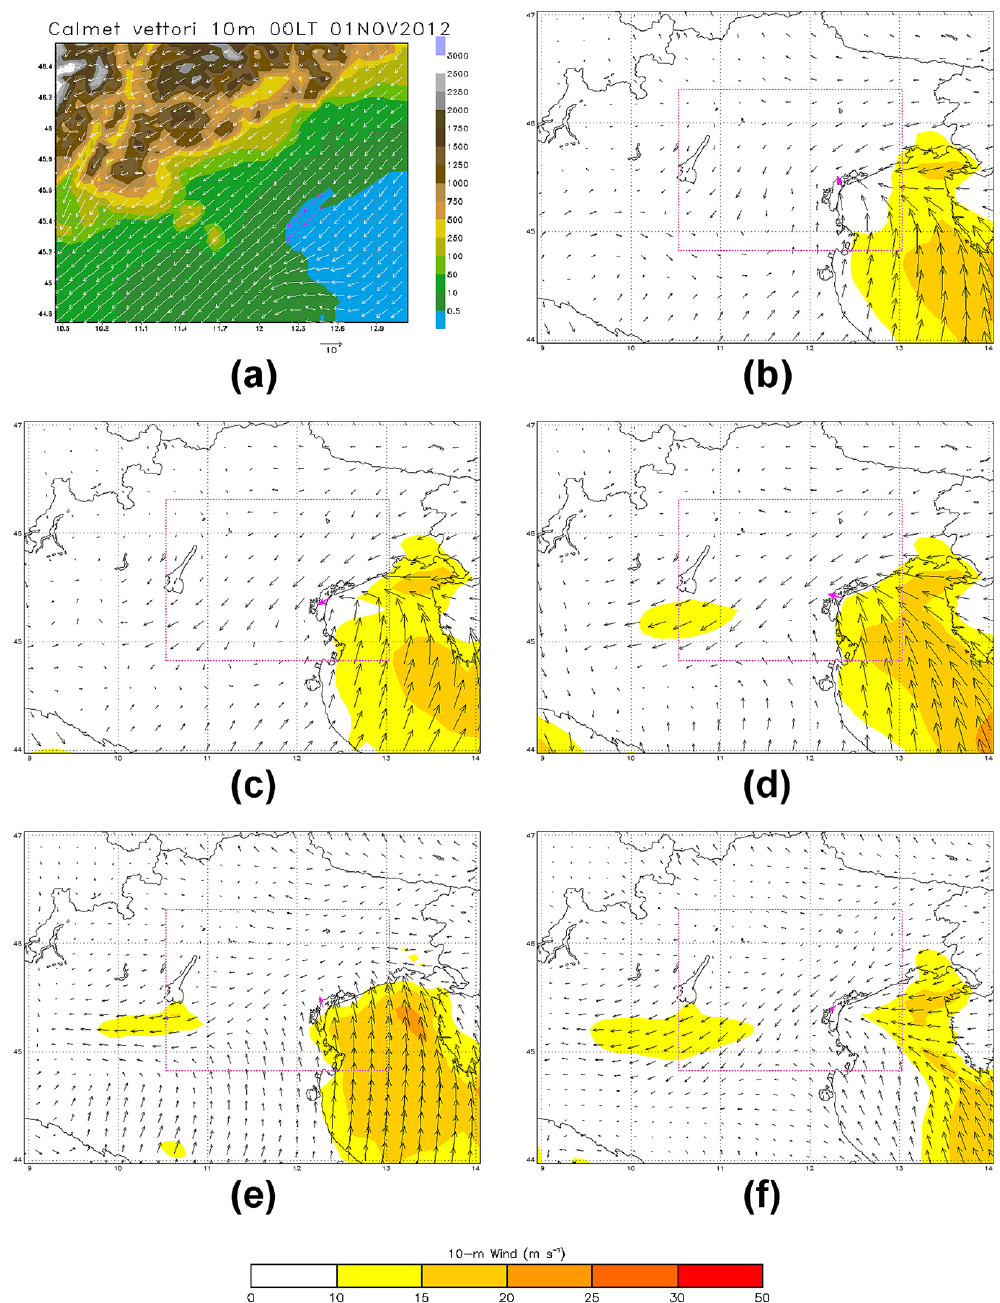
Figure 18. Observed and forecast 10m wind field over NEI at 00:00UTC of 1 November 2012. (a) The CALMET wind analysis – courtesy of ARPA Veneto; (b) 0.1 ◦ BOLAM forecast initialised at 12:00UTC of 28 October 2012. (c) As in (b) , but for the forecast initialised at 12:00UTC of 29 October 2012; (d) As in (b) , but for forecast initialised at 12:00UTC of 30 October 2012; (e) 0.07 ◦ BOLAM forecast initialised at 12:00UTC of 29 October 2012; (f) As in (e) , but for the forecast initialised at 12:00UTC of 30 October